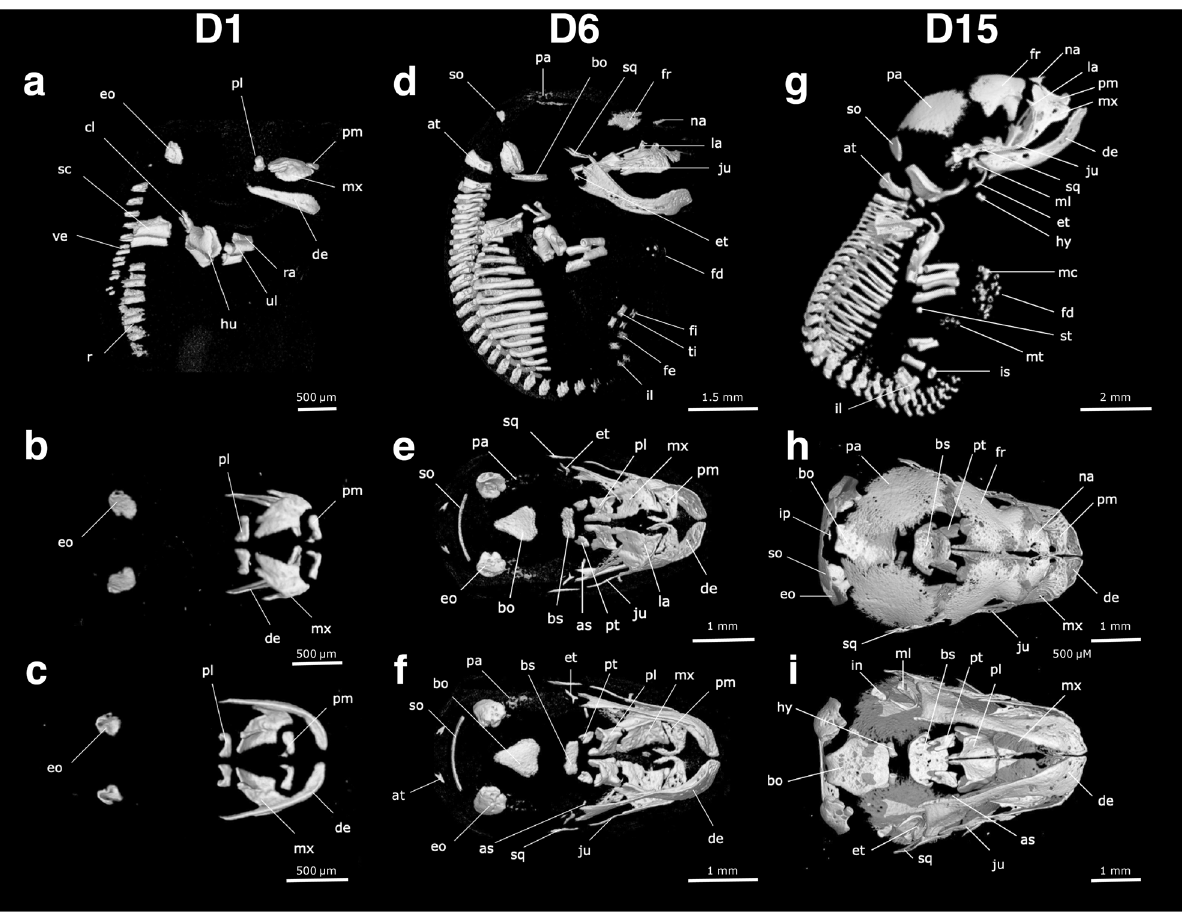
Fig. 4 The skeleton of the fat-tailed dunnart (D1, D6 and D15), as revealed in microCT scans of pouch young. The right lateral side of the skeleton is shown in ( a ), ( d ) and ( g ), the dorsal view of the skull in ( b ), ( e ) and ( h ), and the ventral view of the skull in ( c ), ( f ) and ( i ). Pouch young one day after birth (D1) are shown in ( a ), ( b ) and ( c ). Pouch young six days (D6) after birth are shown in ( d ), ( e ) and ( f ). Pouch young 15 days after birth (D15) are shown in ( g ), ( h ) and ( i ). as = alisphenoid, at = atlas, bo = basioccipital, bs = basisphenoid, cl = clavicle, de = dentary, eo = exooccipital, et = ectotympanic, fd = forelimb digits, fe = femur, fi = fi bula, fr = frontal, hu = humerus, hy = hyoid, in = incus, il = ilium, ip = interparietal, is = ischium, ju = jugal, la = acrimal, mc = metacarpals, ml = malleus, mt = metatarsals, mx = maxilla, na = nasal, pa = parietal, pl = palatine process, pm = premaxilla, pt = pterygoid, ra = radius, ri = ribs, sc = scapula, so = supraoccipital, sq = squamosal, st = sternum, ti = tibia, ul = ulna, ve =